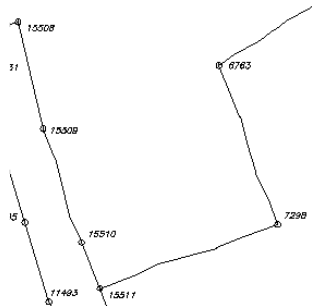
Figure 4. Test using a new AutoCAD line type (Leopoldseder, 2015, p.